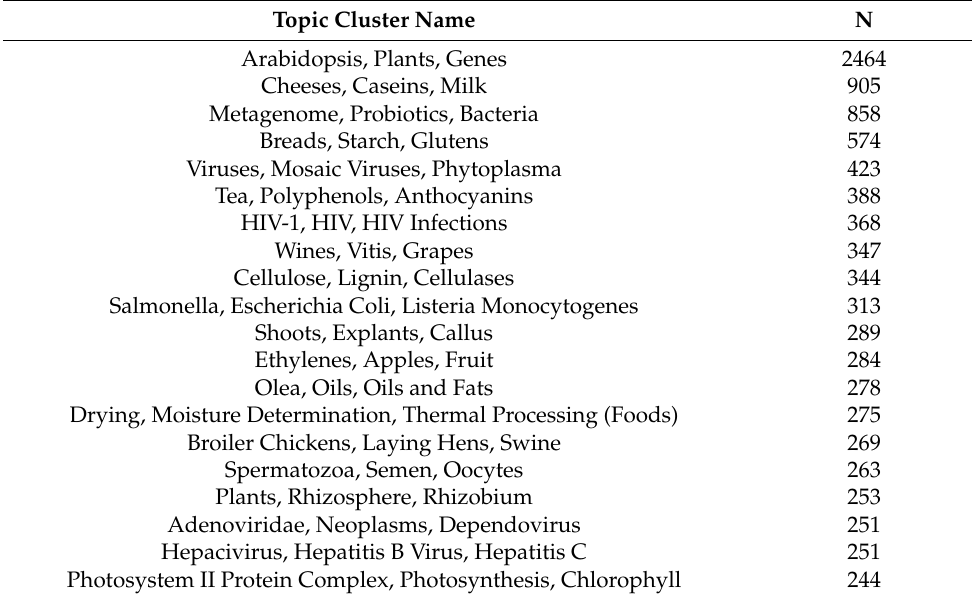
Table 3. Top 20 Topic Cluster names and Topic